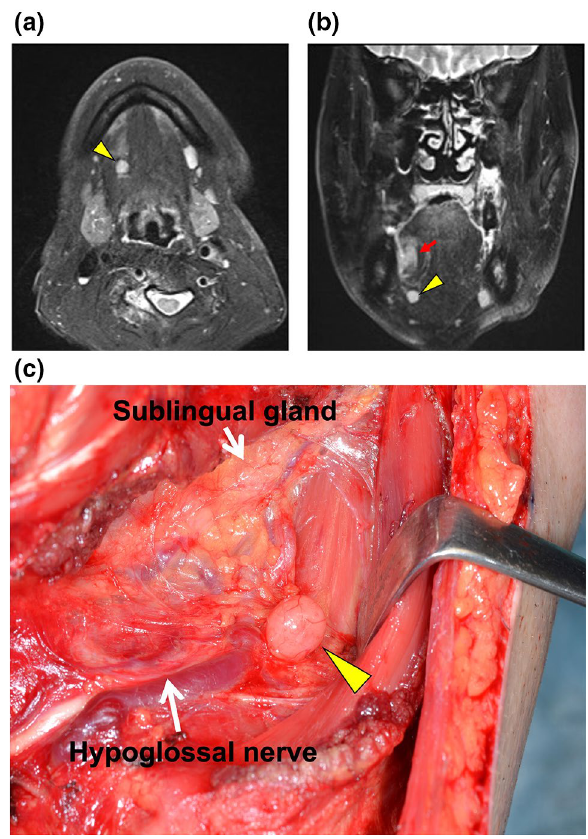
Figure 2. Imaging of lateral lingual lymph node metastasis (LLNM) in the sublingual space. Lateral LLNM (arrowhead) is revealed in the sublingual space on the right side on ( a ) axial T2-weighted magnetic resonance (MR) and ( b ) coronal T2-weighted MR images. This metastatic node is independent of the primary tongue tumor (arrow). ( c ) Lateral LLNM (arrowhead) is located in the proximity of the sublingual gland. The mylohyoid muscle is retracted anteriorly.